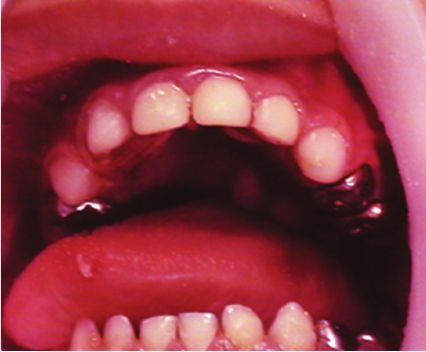
Figure 1: Preoperative Sanjad-Sakati intraoral features. Figure 2: Postoperative restorative first